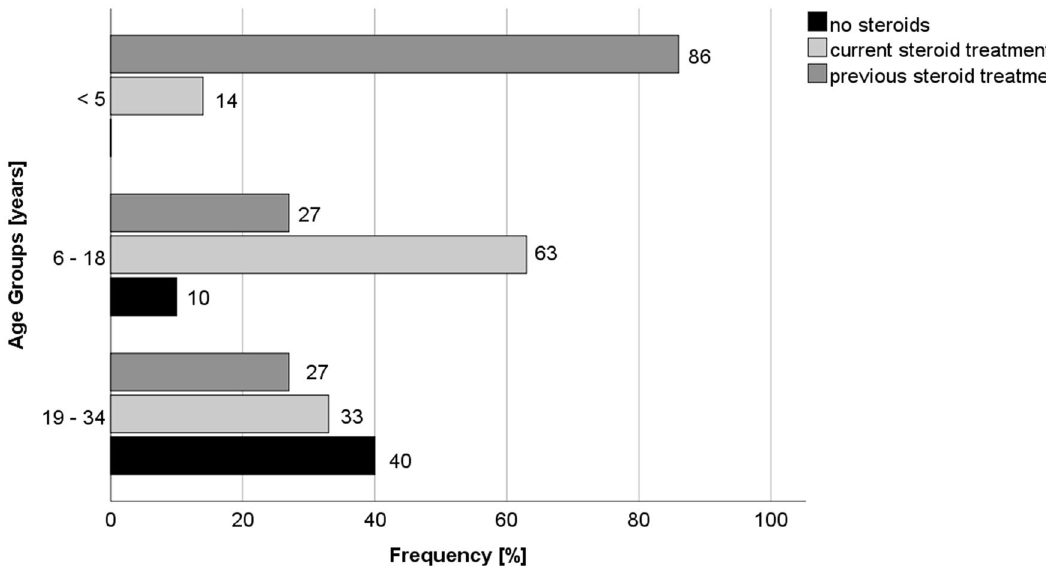
Figure 5. Corticosteroid therapy by age groups (Germany). Treat-NMD/DMD